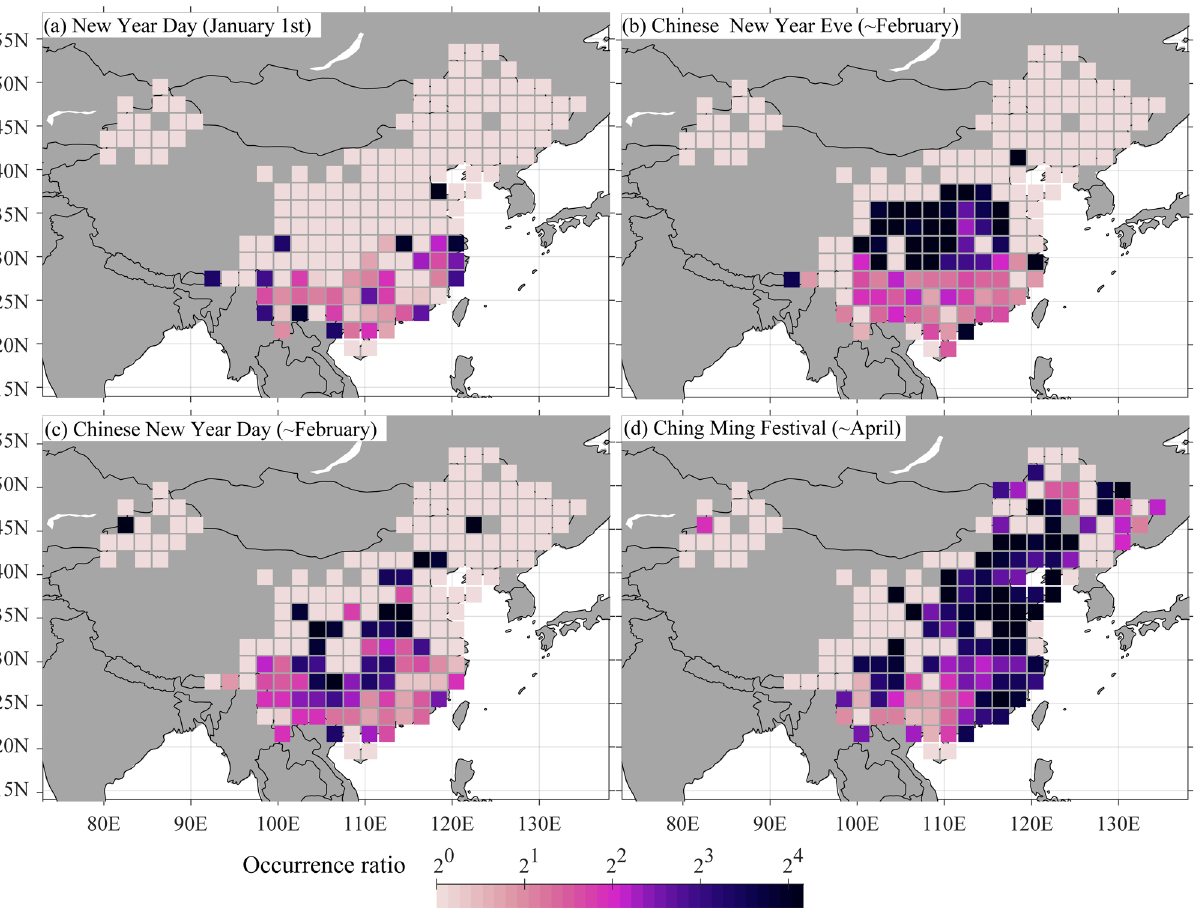
Fig. 3 Fire occurrence ratios between the holidays and the 2005 – 2018 average. The ratio between the fi re occurrences on holidays of a the New Year Day (January 1st), b Chinese New Year Eve (a day before the Chinese New Year, based on the lunar calendar, often in February), c Chinese New Year Day, and d Ching Ming Festival (based on the lunisolar calendar, in April) and the mean daily fi re occurrences (2005 – 2018) in the month of the respective